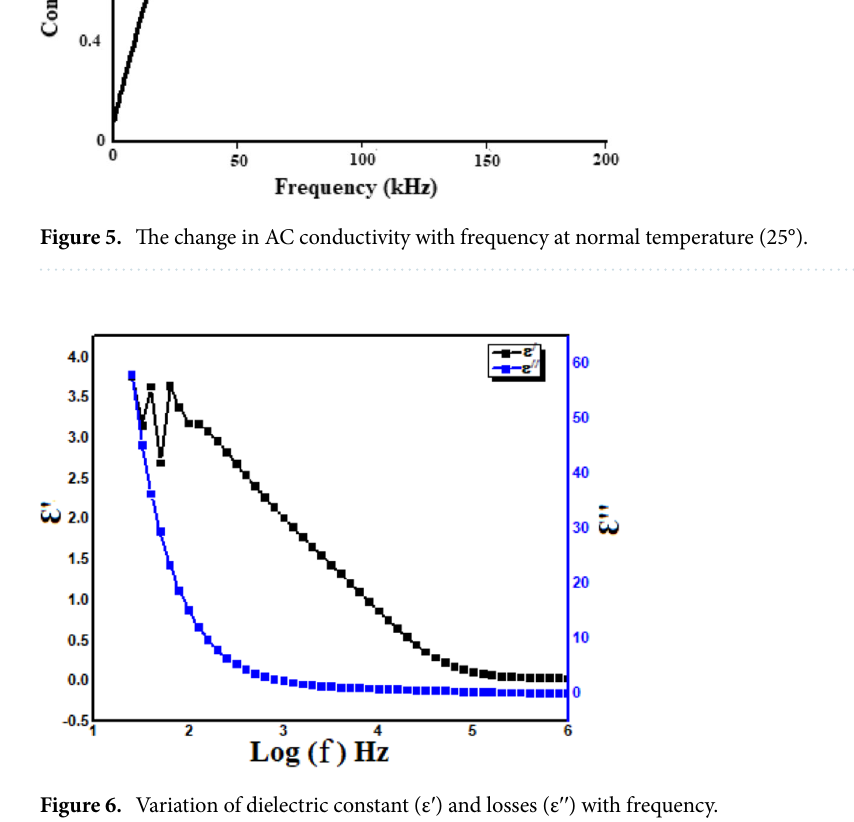
Figure 6. Variation of dielectric constant (ε ʹ ) and losses (ε ʹʹ ) with